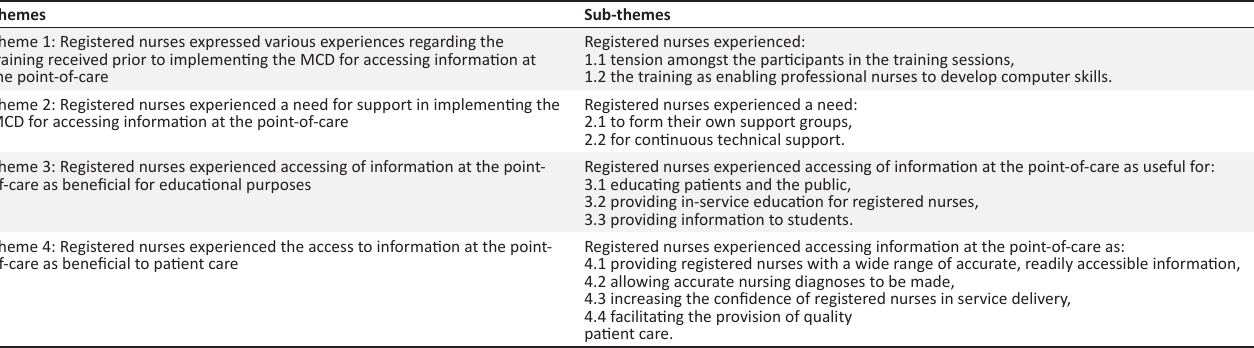
TABLE 1: Themes that emerged from analysis relating to the experiences of the registered nurses regarding accessing information at the point-of-care.